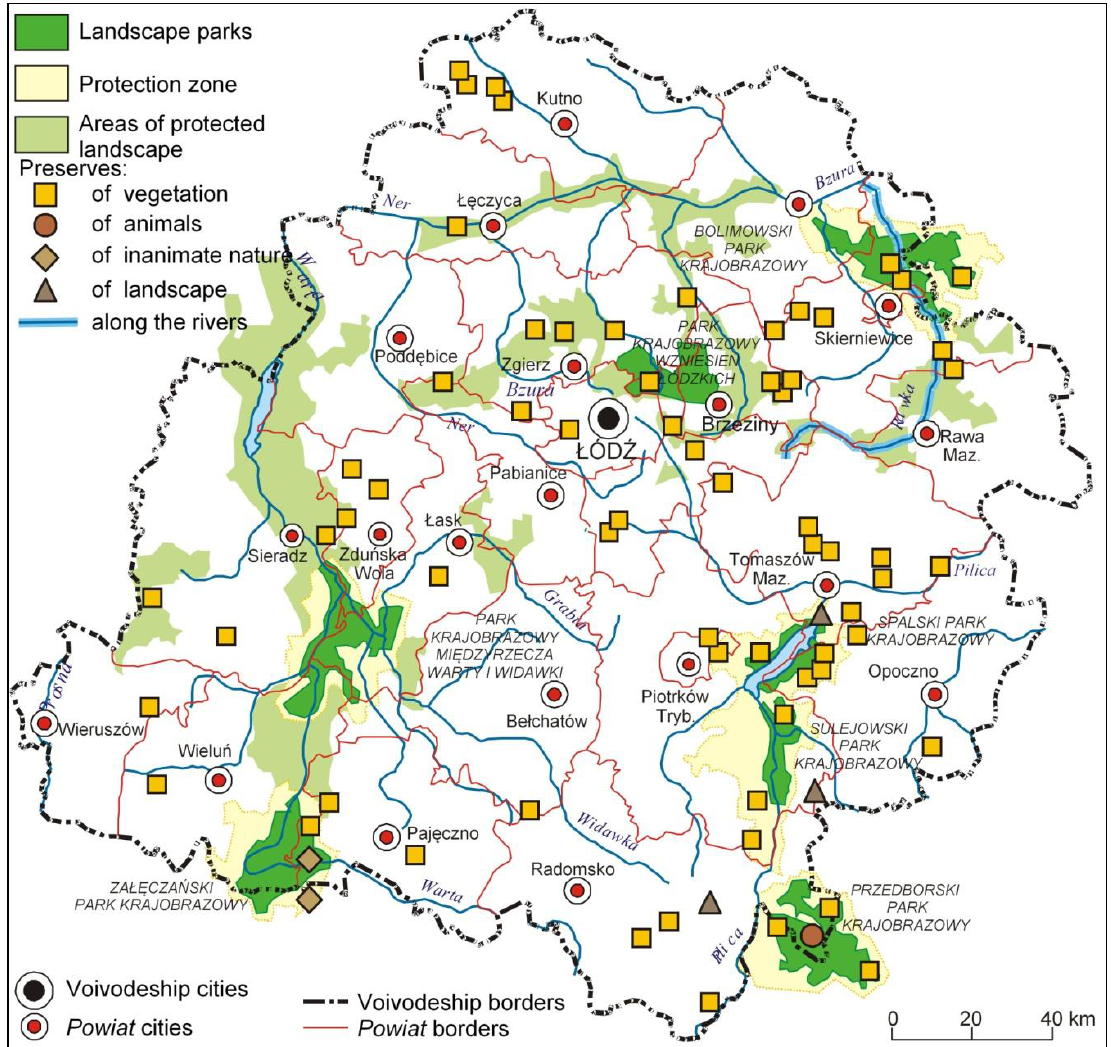
Fig. 3. The main forms of nature protection in the Łódź